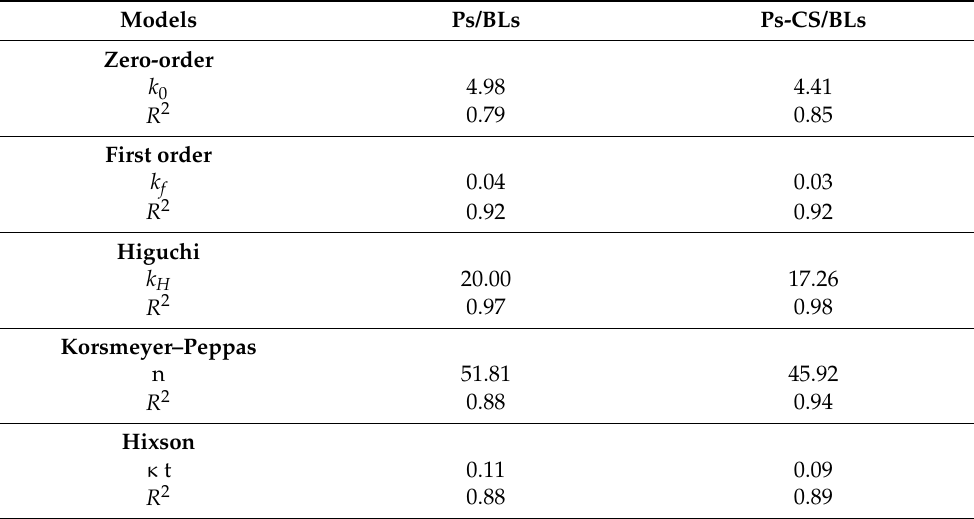
Figure 5. Release kinetics of Ps from Ps-CS/BLs fitted to five kinetic models. Table 2. Rate constants and correlation coefficients ( R 2 ) of Ps released from Ps/BLs and Ps-CS/BLs computed by fitting into five different models (zero-order, First order, Higuchi, Korsmeyer–Peppas, and Hixson